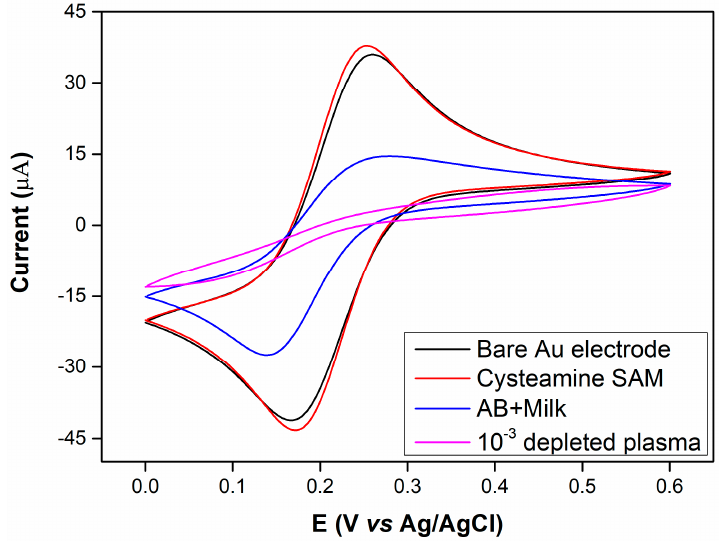
Figure 2. Cyclic voltammetries (CVs) (scan rate: 50 mV s − 1 ) of bare Au electrode (black line), Au/Cysteamine-SAM (red line), Au/Cysteamine-SAM /Polyclonal rabbit Anti-human IgG/1% milk (blue line), Au/Cysteamine-SAM /Polyclonal rabbit Anti-human IgG/1% milk /10 − 3 plasma dilution (pink line). Tested in 10 mM PBS containing 5 mM [Fe (CN) 6 ] 4 − /3 − and 150 mM NaCl. Electrode surface area: 0.02 cm 2 .